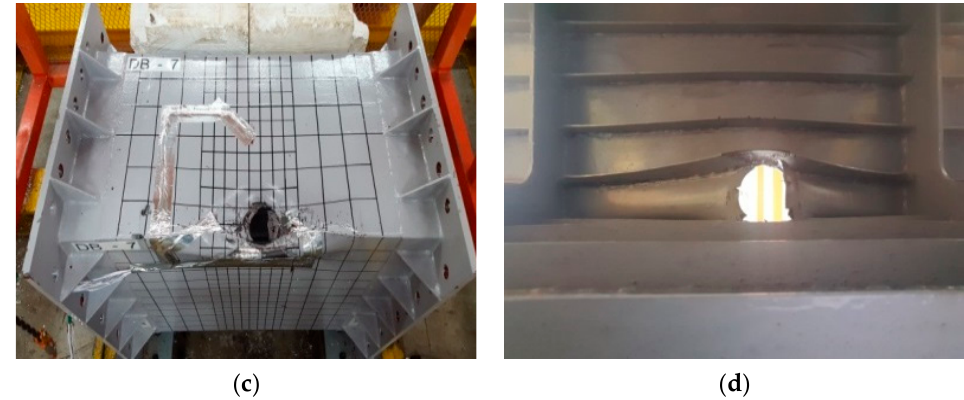
Figure 8. The deformed shape of the model: ( a ) DB-5: exterior view; ( b ) DB-5: interior view; ( c ) DB-7: exterior view; ( d ) DB-7: interior view.